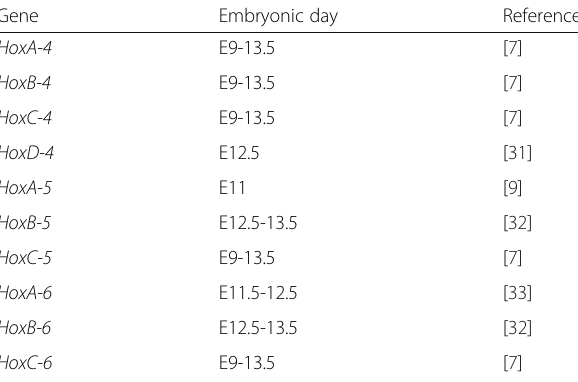
Table 3 References for somitic Hox gene expression pattern in the mouse. The literature survey focused on embryonic stages at which somitic Hox gene expression limits are thought to be well established and stable during further development